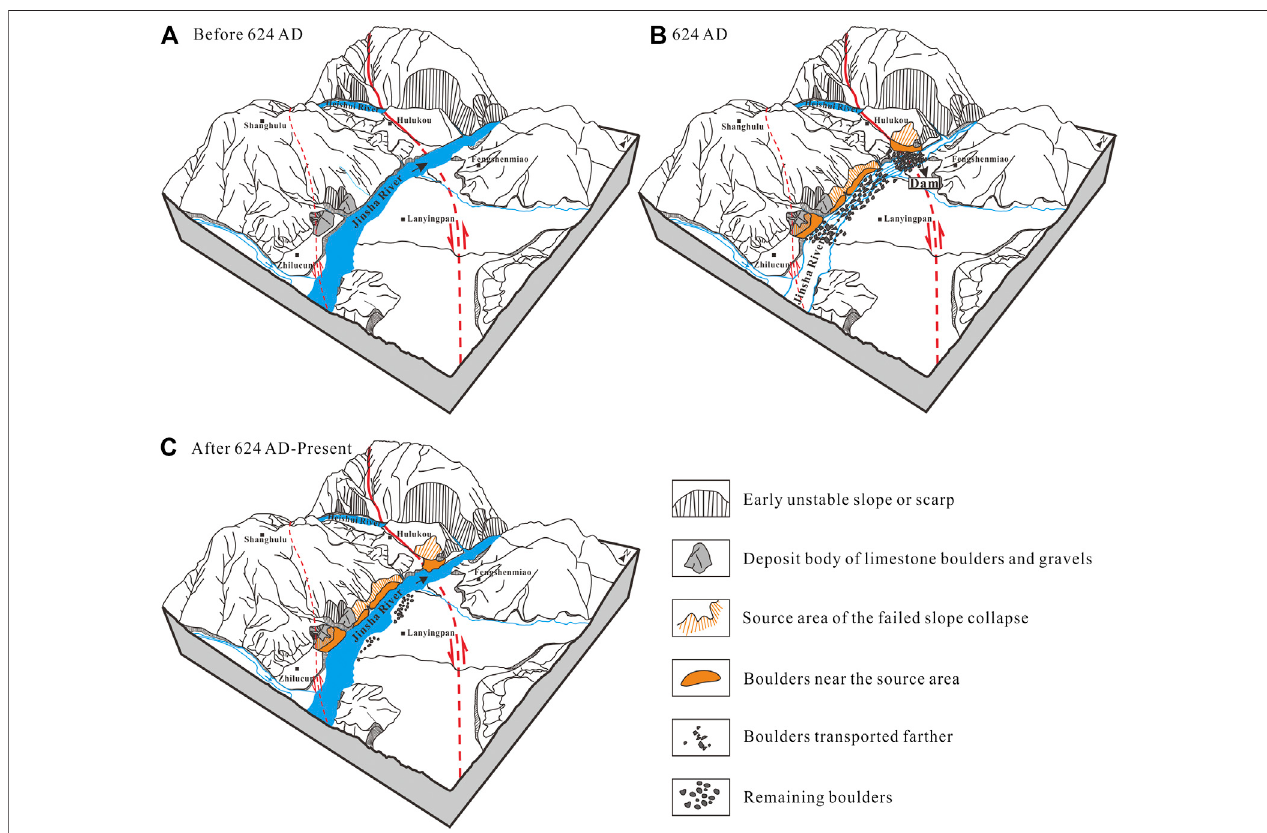
FIGURE 11 | The sketch process of the 624 AD failed slope